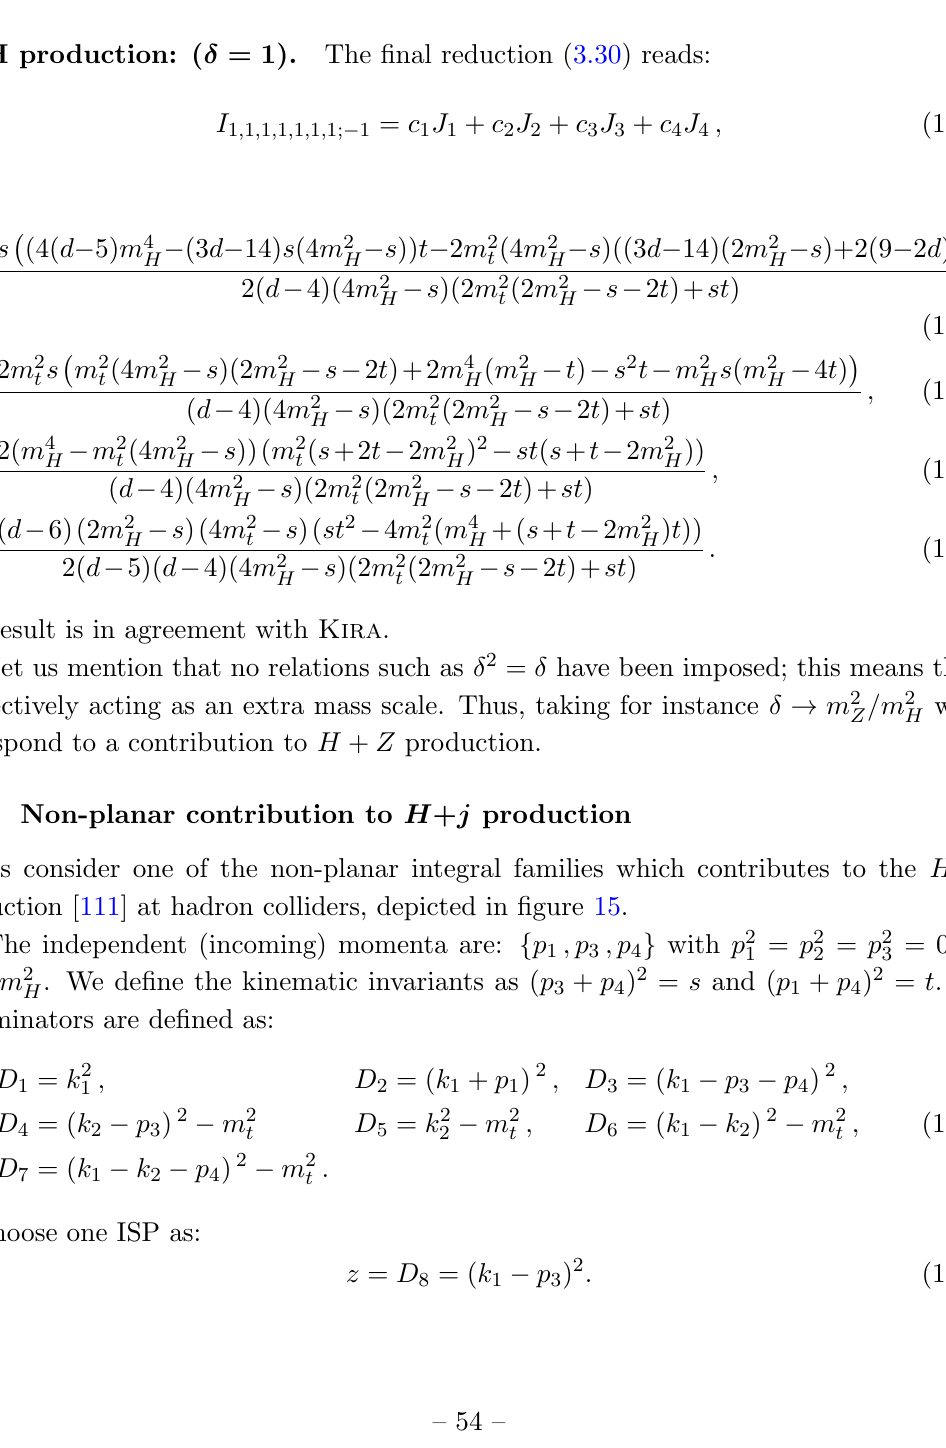
Figure 15. Non-planar ( H + j